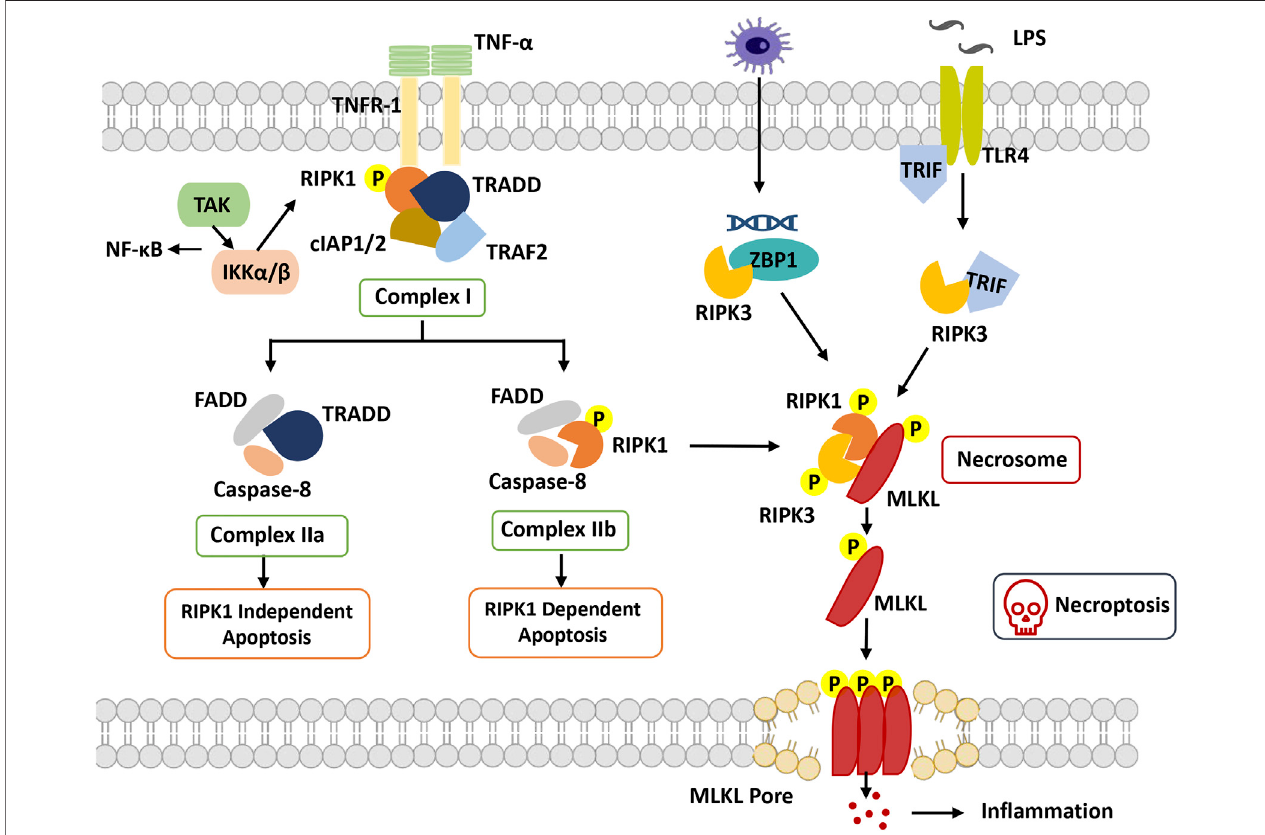
FIGURE2| Overviewofnecroptosis.WithstimulationofTNF α ,TNFR1recruitsTRADDandbindswithRIPK1,combiningwithTRAF2andcIAP1/2toformcomplex I.RIPK1canbeubiquitinatedbycIAP1/2,whichpromotesdissociationofTRADDandRIPK1fromcomplexItotriggerapoptosisornecroptosis.Inapoptosis,FADDand caspase-8arerecruitedtoTRADDandRIPK1,respectively,toformcomplexIIaandcomplexIIb.Caspase-8isactivated,andapoptosisisinduced.Innecroptosis,when caspase-8 is inhibited, RIPK1 phosphorylates and activates RIPK3 to form necrosome complexes and phosphorylate MLKL. Phosphorylated MLKL undergoes oligomerization and migrates to the plasma membrane, where it induces necroptosis by initiating membrane rupture. Abbreviation: cIAP, cellular inhibitors of apoptosis protein; FADD, Fas-associated death domain; IKK α / β , IkB kinase α / β ; MLKL, mixed lineage kinase domain-like protein; RIPK1, receptor-interacting protein kinase 1; RIPK3, receptor interacting protein kinase 3; TAK1, beta-activated kinase 1; ITLR, toll-like receptor; TRADD, TNF receptor-associated death domain; TRAF, TNF receptor-associated factor; TRIF, TIR-domain-containing adapter-inducing interferon- β ; ZBP1, Z-DNA-binding protein 1.